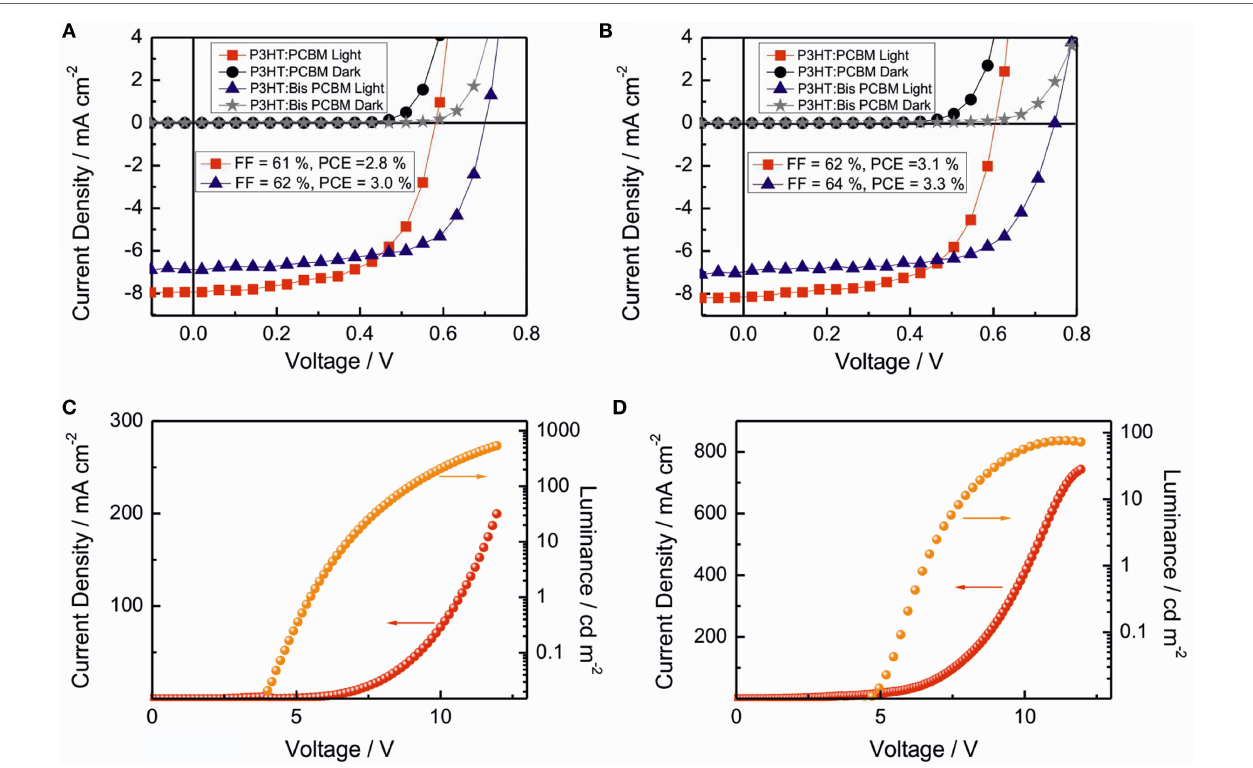
FigUre 4 | J–V and l–J–V characteristics of standard and inverted BhJ OPVs and OleDs: (a) glass/iTO/PeDOT:Pss/P3hT:PcBM or bis-PcBM/liF/ al, (B) glass/iTO/Pei/P3hT:PcBM or bis-PcBM/MoO x /ag, (c) glass/iTO/PeDOT:Pss/aDs200re/ca/ag, and (D) glass/iTO/Pei/aDs200re/MoO x /ag configurations, respectively